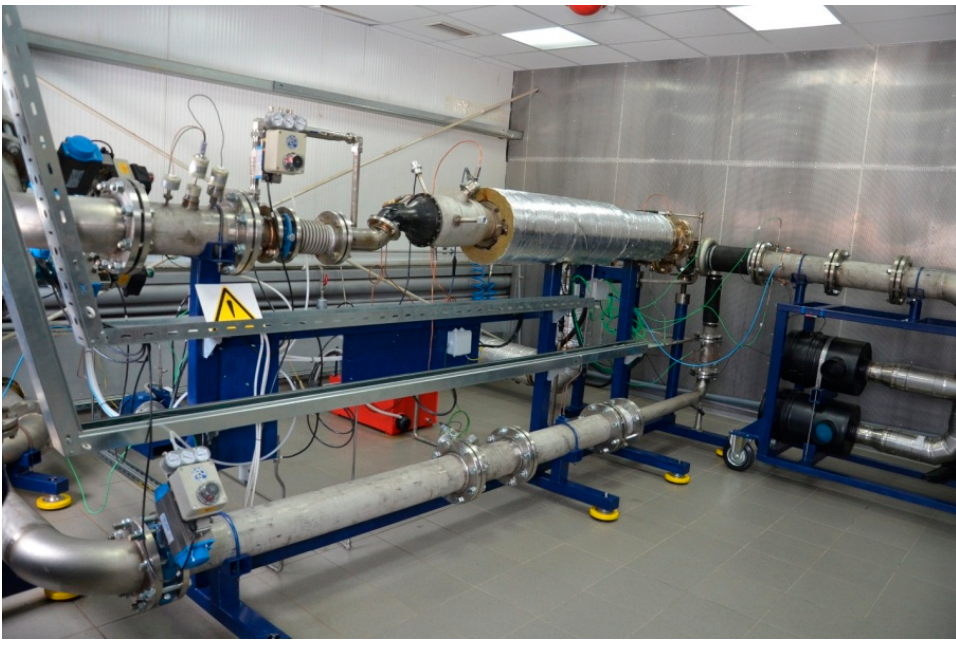
Figure 7. Test rig for turbocompressors in RPA “Turbotekhnika”.